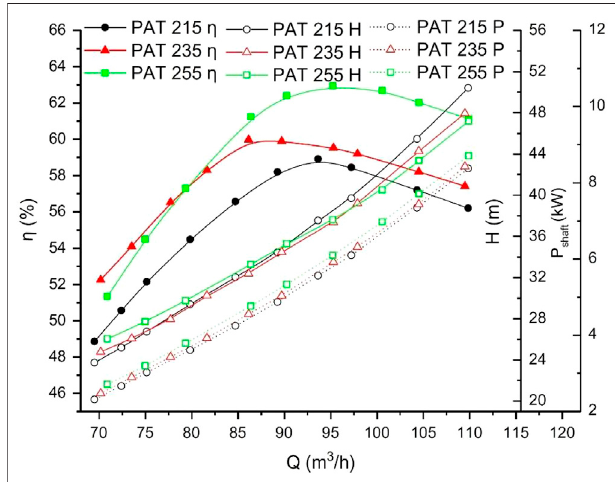
FIGURE4| Performance curves ofPATwithdifferentimpellerdiameters (Yang et al., 2012b).